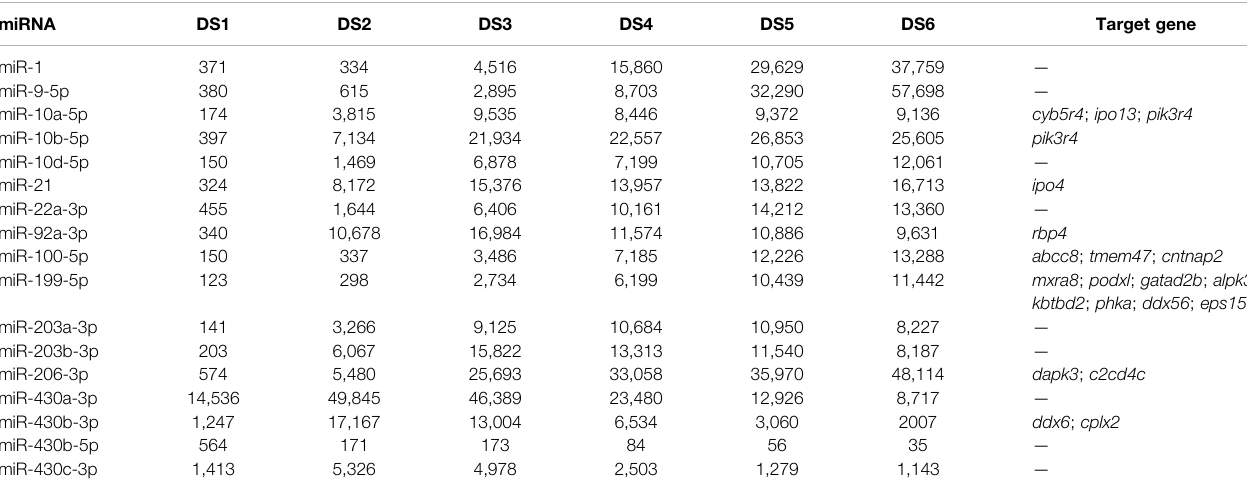
DS,developmentalstage;abcc8,ATPbindingcassettesubfamilycmember8;alpk3,alphakinase3;c2cd4c,C2calciumdependentdomaincontaining4c;cntnap2,contactinassociated protein 2; cplx2, complexin 2; cyb5r4, cytochrome b5 reductase 4; dapk3, death associated protein kinase 3; ddx6, DEAD-box helicase 6; ddx56, DEAD-box helicase 56; eps15l1, epidermalgrowthfactorreceptorpathwaysubstrate15like1;gatad2b,GATAzinc fi ngerdomaincontaining2b;ipo4,importin4;ipo13,importin13;kbtbd2,kelchrepeatandBTBdomain containing 2; mxra8, matrix remodeling associated 8; phka, phosphorylase kinase regulatory subunit alpha; pik3r4, phosphoinositide-3-kinase regulatory subunit 4; podxl, podocalyxin like; rbp4, retinol binding protein 4; tmem47, transmembrane protein